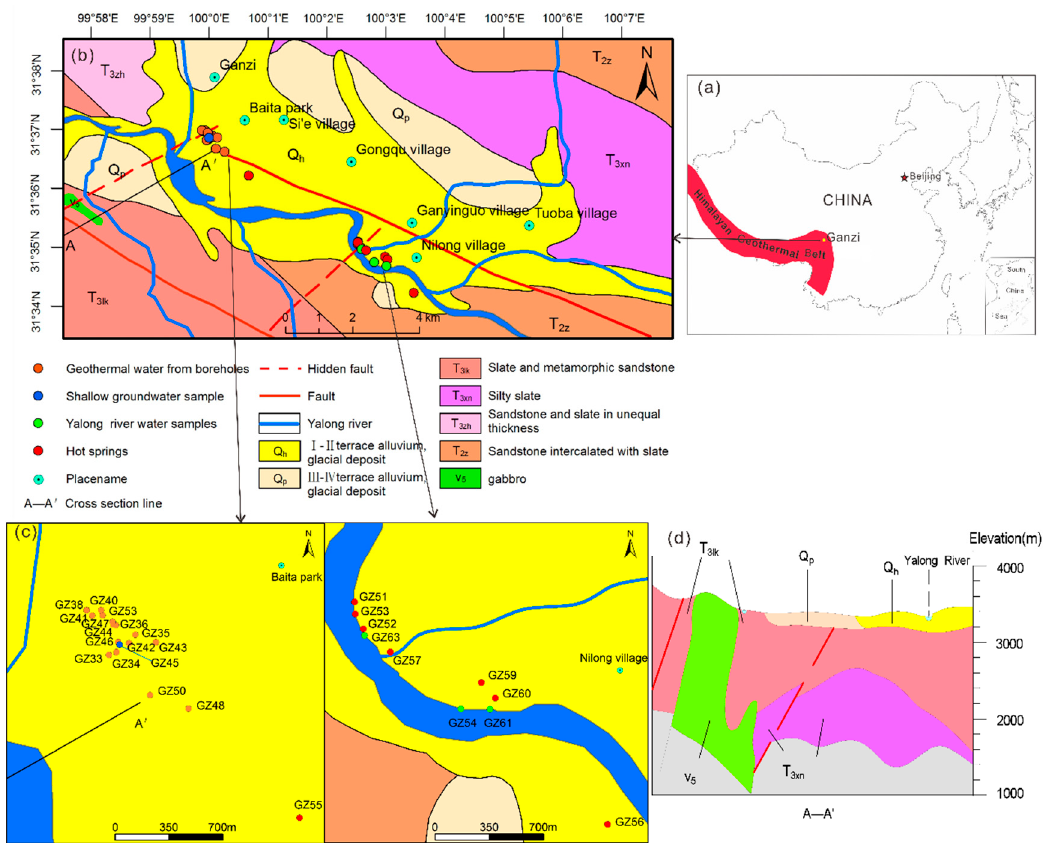
Figure 1. ( a ) location of the Himalayan geothermal belt and the study area [10], ( b ) Geological setting of the Ganzi geothermal field, ( c ) sampling sites, ( d ) cross section of the Ganzi region.